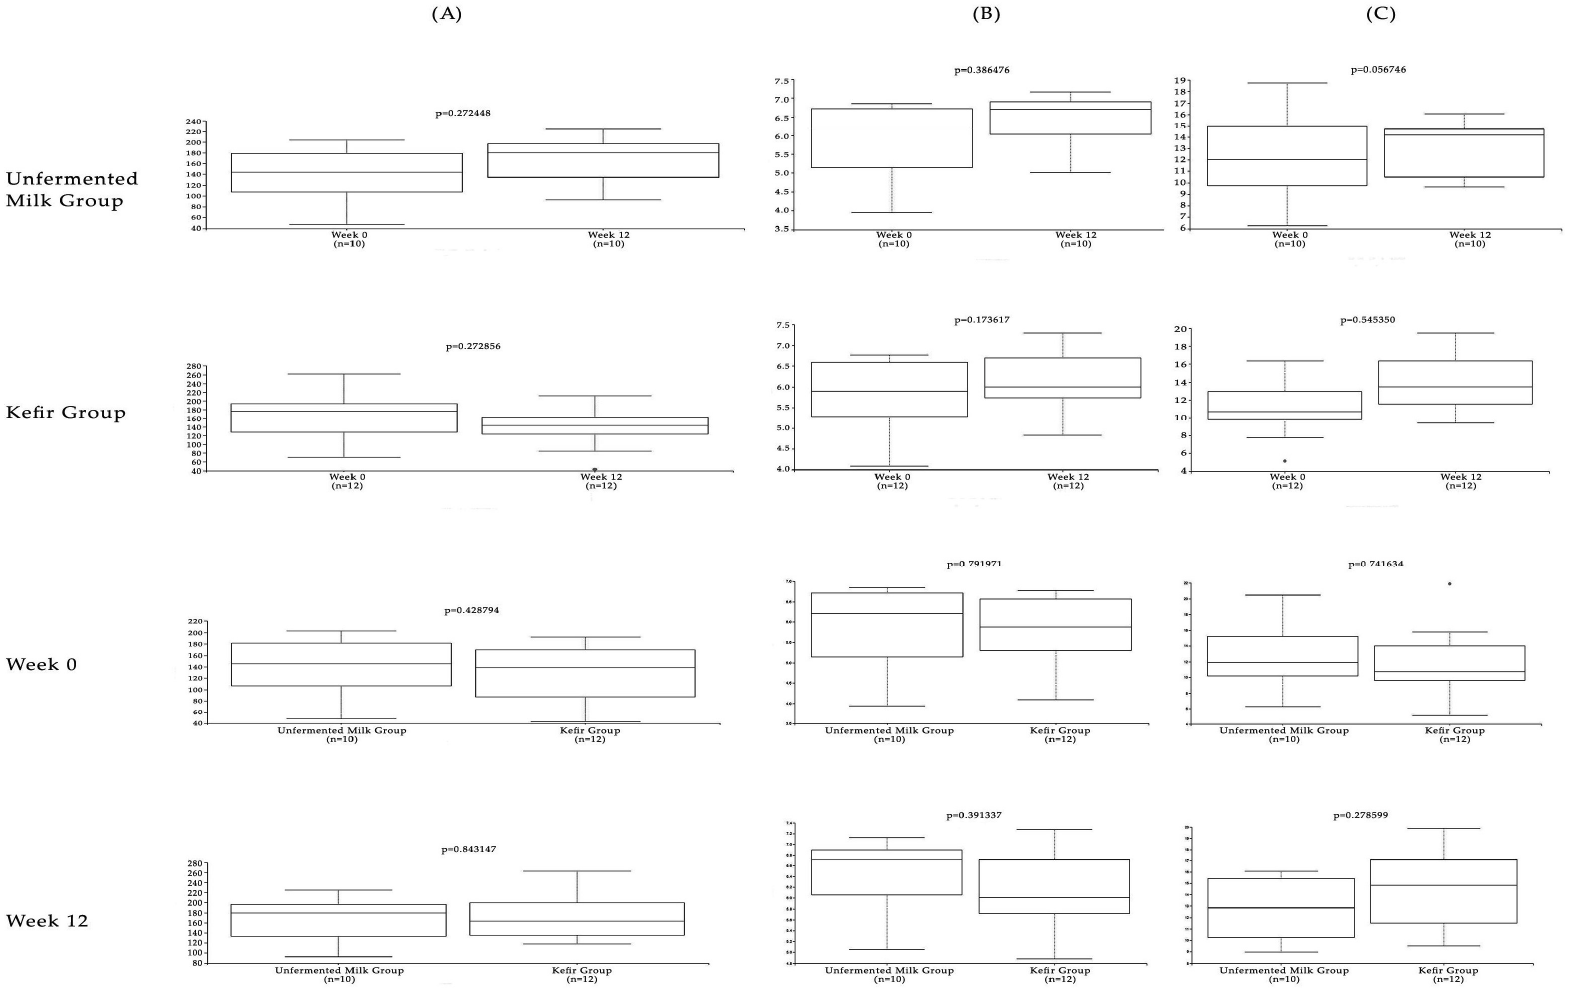
Figure 4. Box–and–whisker plots of the alpha diversity metrics calculated for the study groups. The box represents the median and the interquartile range, whereas whiskers indicate the 90th and 10th percentiles ( A : Observed OTUs, B : Shannon index, C : Faith phylogenetic diversity index).